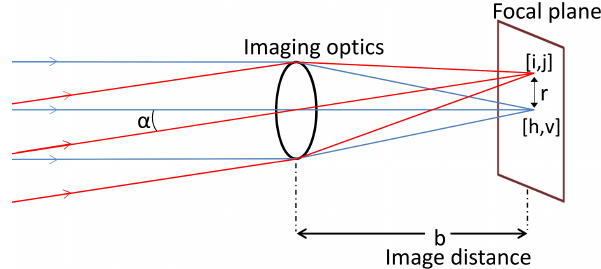
Figure 7. A ray diagram showing projections for the on-axis and an off-axis pixel. The [ h,v ] coordinates represent the on-axis position, [ i,j ] represent the coordinates of an off-axis pixels, r is the distance from the optical axis, α is the off-axis angle, and b represents the image distance (sketch modified from Davis et al., 2001).